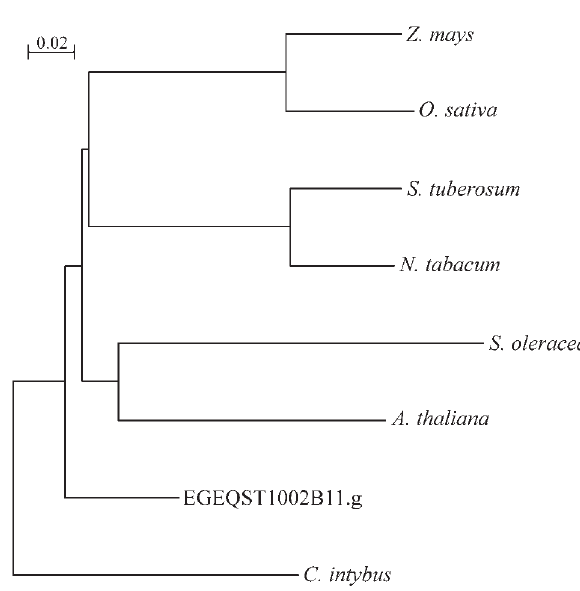
Figure 5 - Graphical representation of the phylogenetic distances ob- tained from amino acid sequences corresponding to the end region of the enzyme protoporphyrinogen IX oxidase of the studied